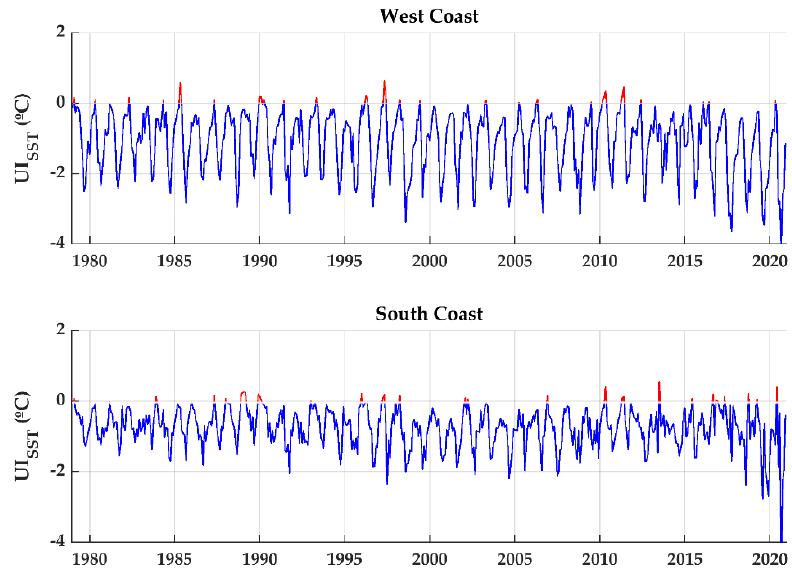
Figure 7. Spatial averages of the evolution of UI SST (°C) on the Portuguese west and south coasts over the period 1979–2020. The red line represents positive values, and the blue line represents negative values.